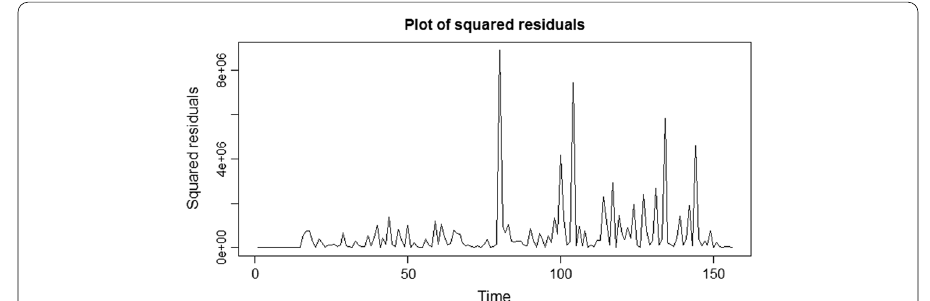
Fig. 3 Plot of the residual squares of model in Eq. (11) from preliminary model